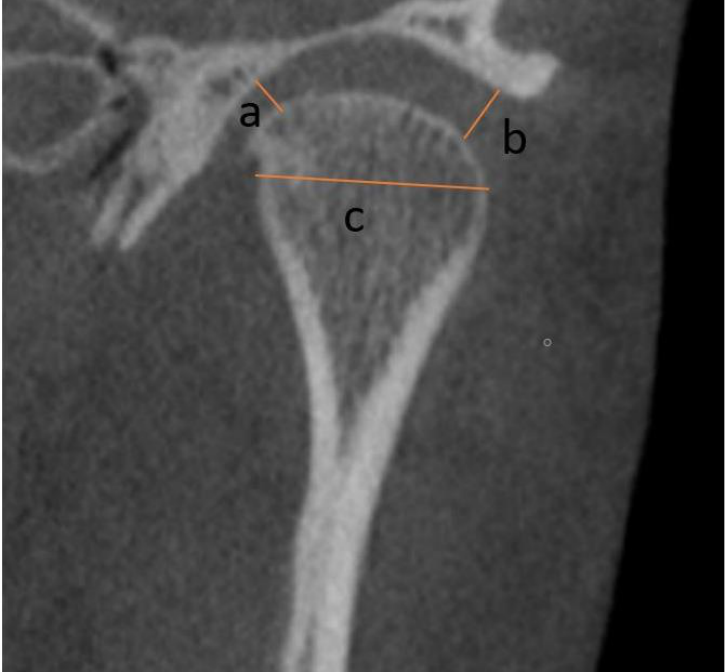
Figure 3. Coronal view. a — medial joint space; b — lateral joint space; c — mediolateral condyle thick- ness.